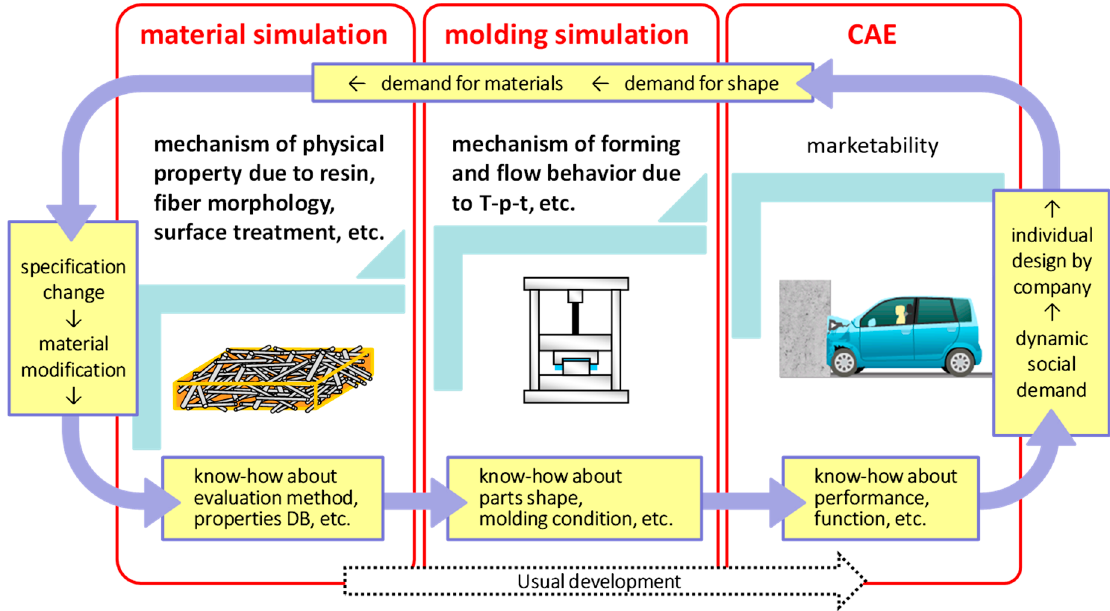
Figure 20. Development flow of CFRTPs for automotive mass production.